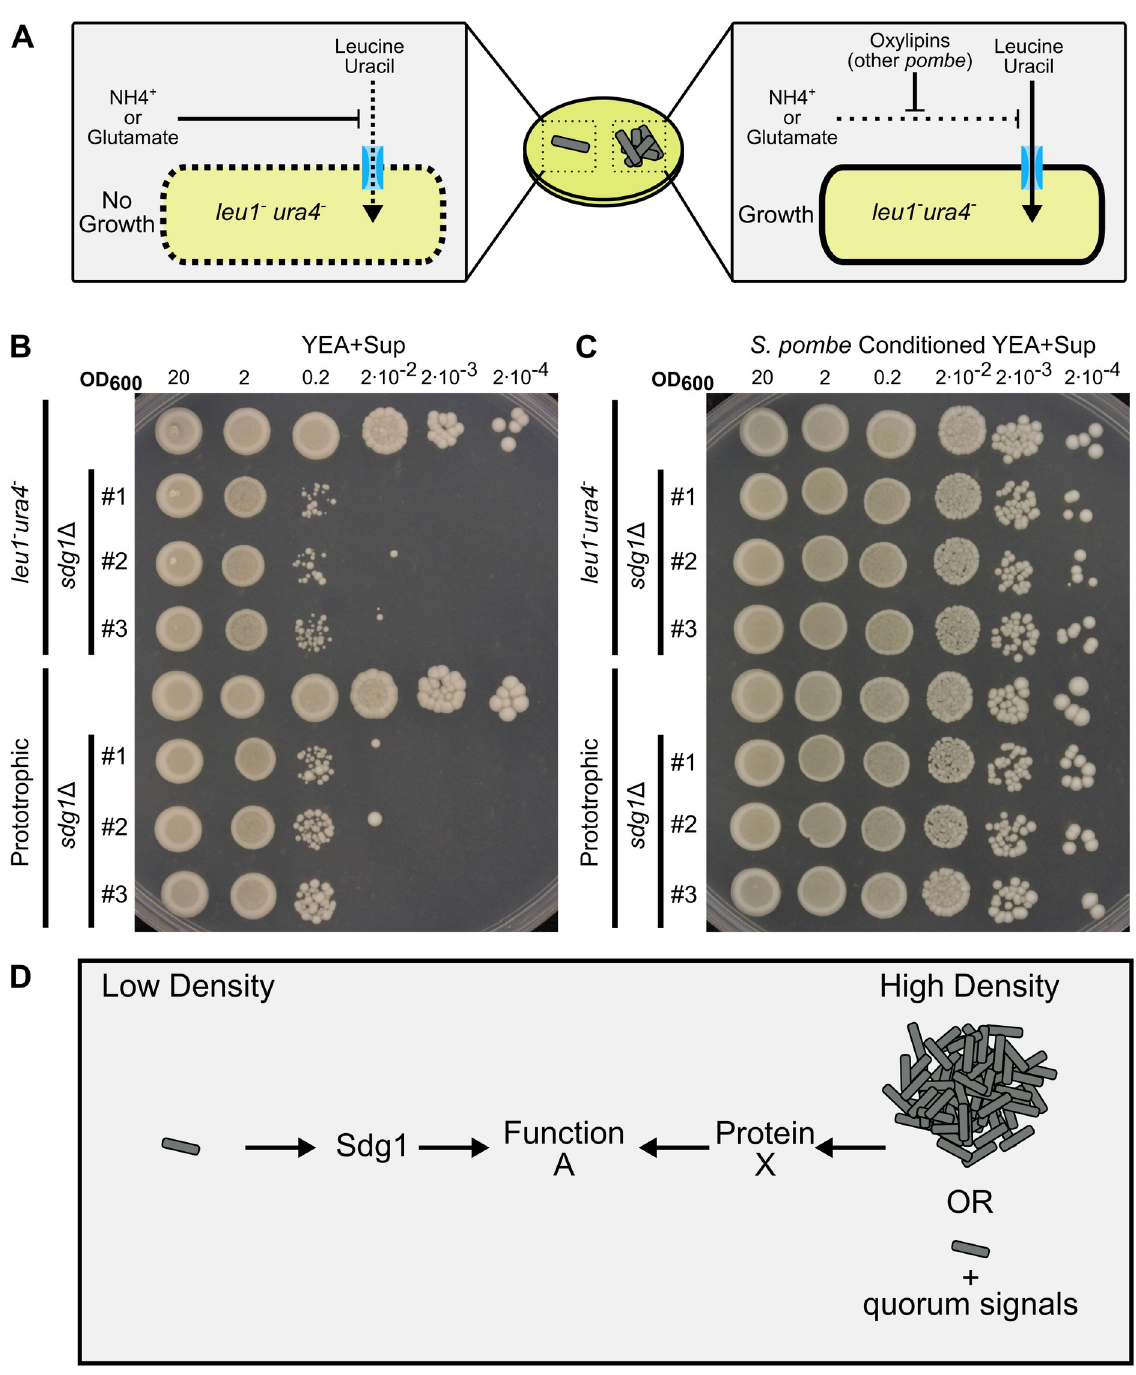
Fig 7. The sdg1 Δ mutant phenotype is not the result of a previously described quorum effect. A) Diagram illustrating current model of oxylipin mediated quorum sensing in S . pombe . Some nutrient uptake is repressed by ammonia or glutamate in the medium. As a result, auxotrophs may fall to grow even in the presence of the appropriate amino acids (left). However, this repression can be alleviated by oxylipins that are produced as a quorum molecule (right). Consequently, many S . pombe auxotrophs fail to grow at low cell density. B-C) Spot dilution assays with 5 μ L spots plated. The initial leftmost spot is of OD 600 = 20 culture and each successive spot is a 10-fold dilution, so that the final spot should be 10 5 less concentrated than the first. Both experiments were conducted on the same day with the same dilution series of parent strain, three independent sdg1 Δ mutants on the same background ( sdg1 Δ :: kanMX4 , ura4 -D18, leu1 -32), one wild type strain and three independent prototrophic sdg1 Δ mutants ( sdg1 Δ :: kanMX4 ).Dilution series are from different cultures from those in Fig 5B) Spotted to standard yeast extract agar (YEA+SUP) and incubated for 4 days at 32˚C. C) Spotted to conditioned yeast extract agar made from